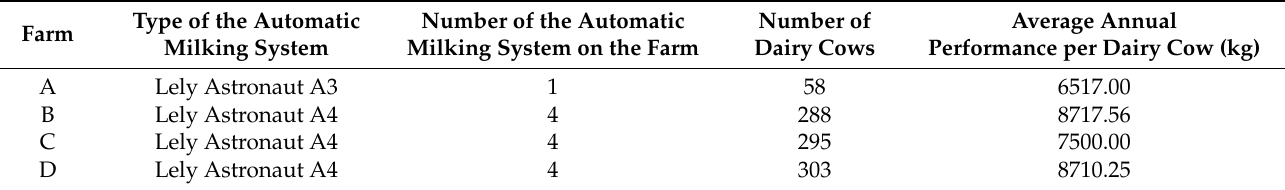
Table 1. Description of the dairy